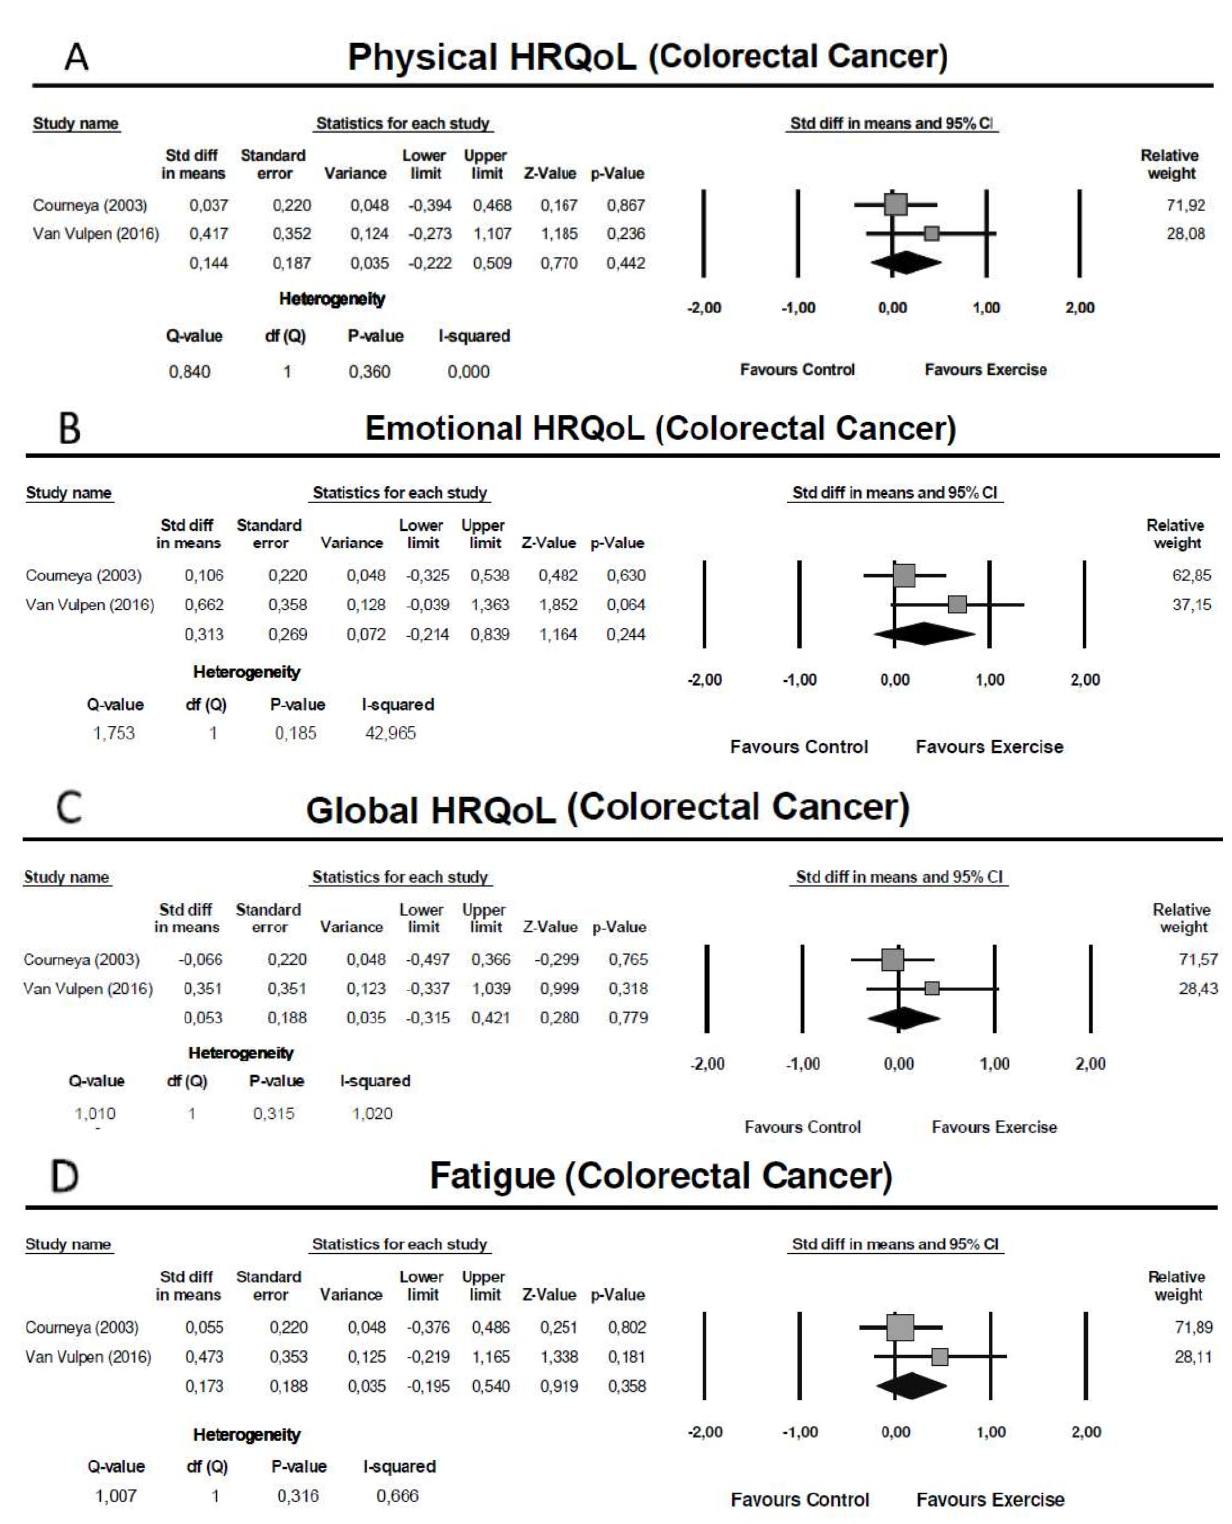
Figure 4. Meta-analysis for the effect estimate of exercise training in colorectal cancer patients: (A) Physical domain; (B) Emotional Domain; ( C) Global health-related quality of life; (D) Fatigue.